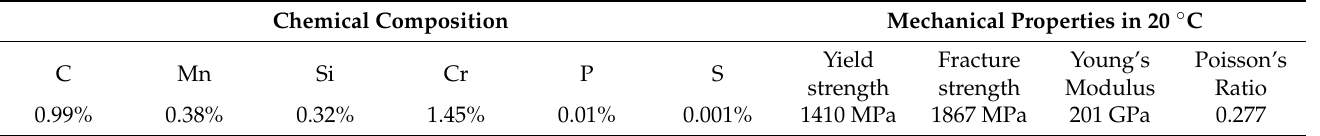
Table 1. The chemical composition and mechanical properties of AISI 52100 steel [24,25].